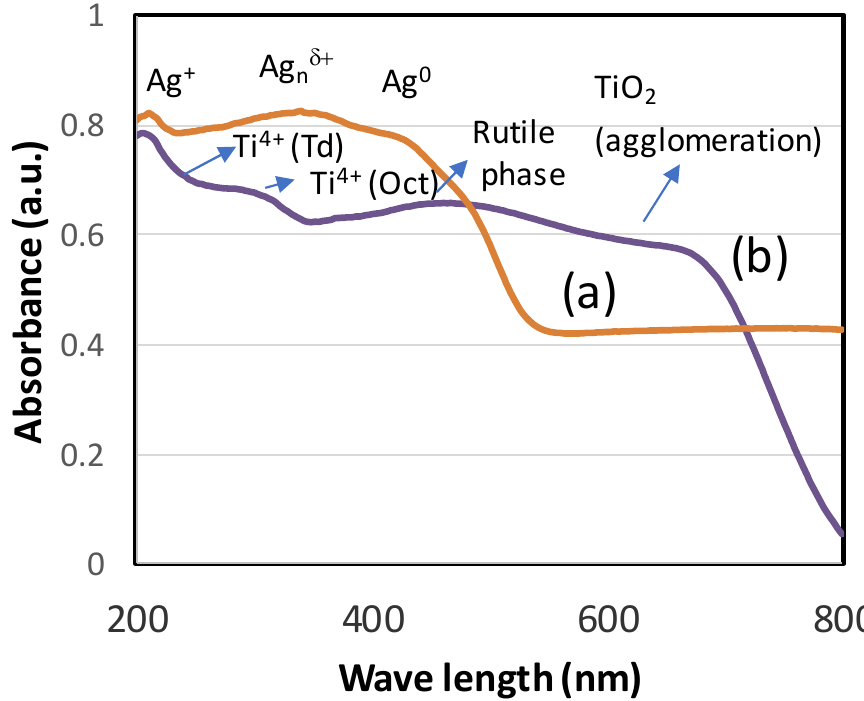
Figure 3. Di ff use reflectance UV-visible spectra of ( a ) Ag NPs and ( b ) TiO 2 NPs. The spectra ( a ) shows Figure 3. Diffuse reflectance UV-visible spectra of (a) Ag NPs and (b) TiO 2 NPs. The spectra (a) shows existence of Ag + , Ag n δ + and Ag 0 species and ( b ) shows isolated Ti(IV), Octahedral Ti and rutile phase existence of Ag+, Ag nδ+ and Ag 0 species and (b) shows isolated Ti(IV), Octahedral Ti and rutile phase of TiO 2 of TiO 2 NPs.